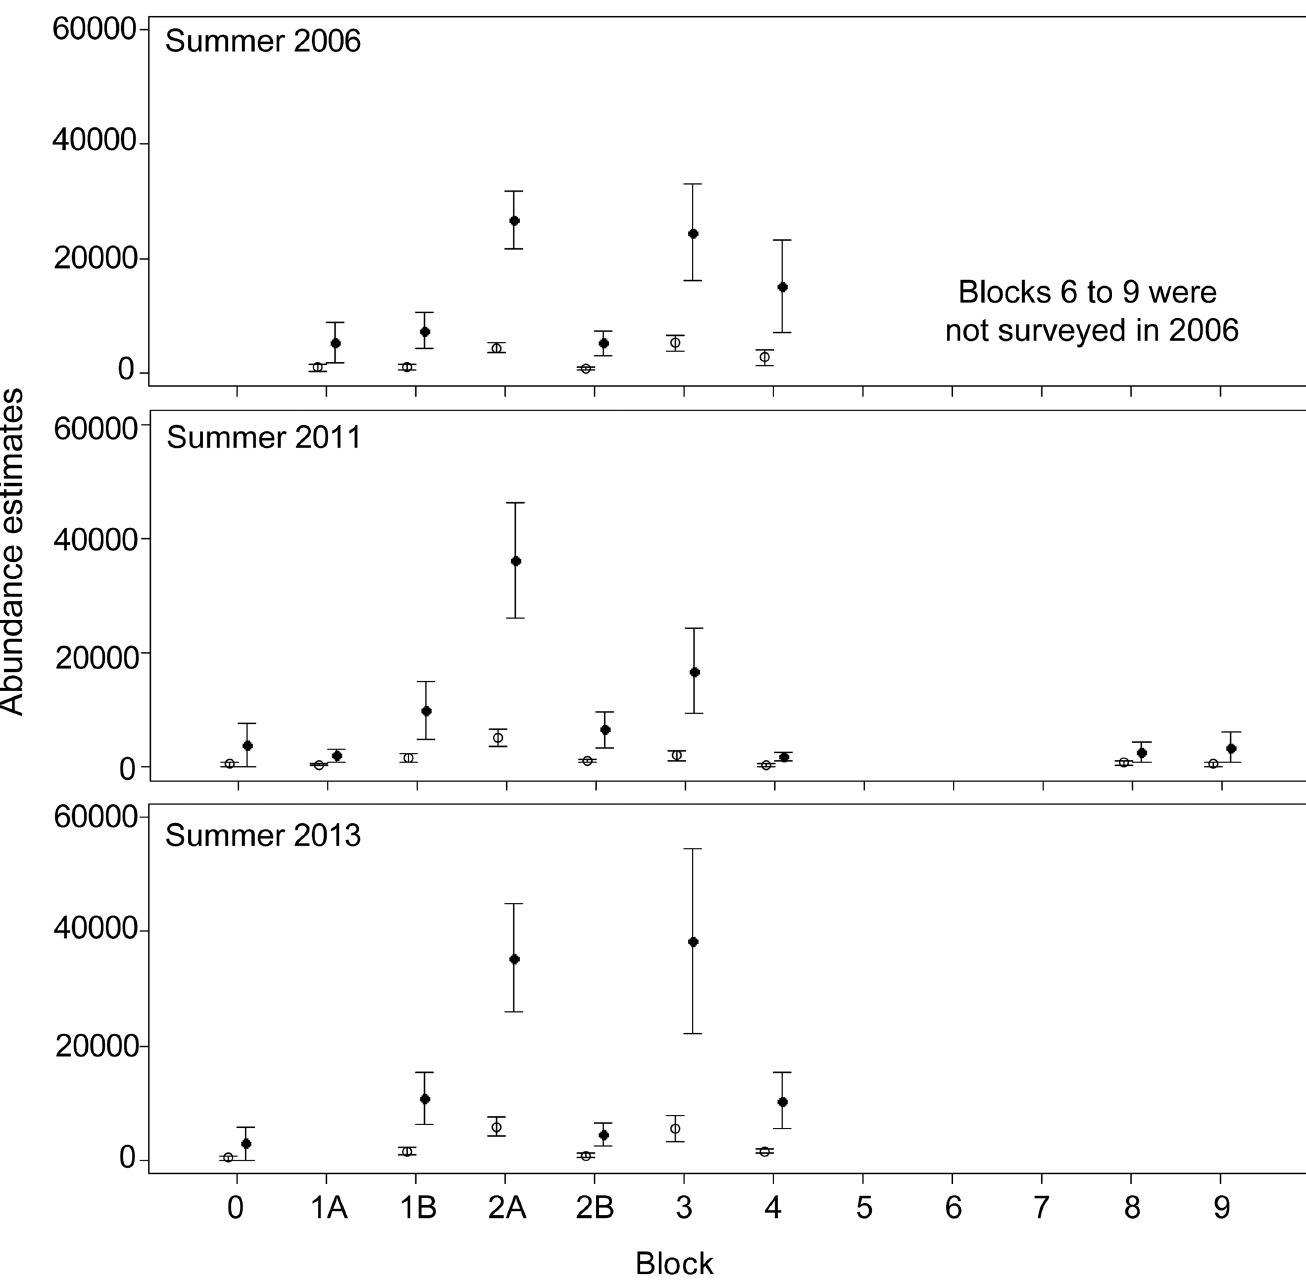
Fig 3. Population abundance estimates (± SE) (vertical lines) in Torres Strait obtained using the availability detection probabilities from Pollock et al. [18] (open circles) and this study (closed